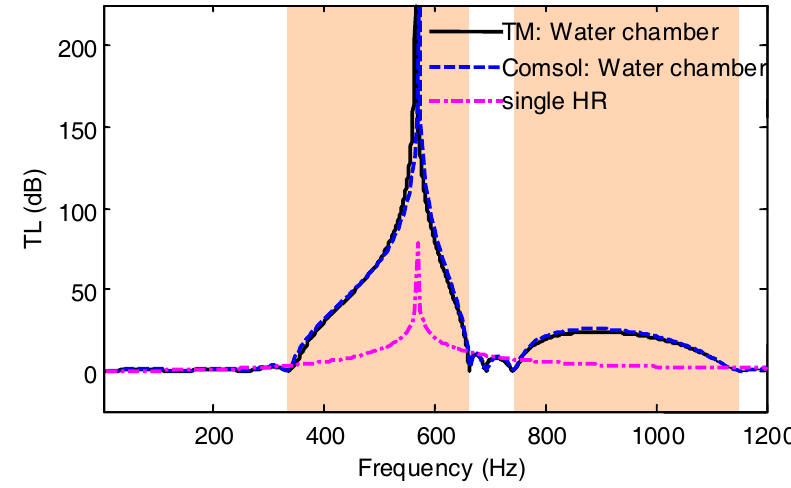
Figure 2. Sound transmission losses for the seawater pipe system with a single HR and a HR array mounted, respectively.